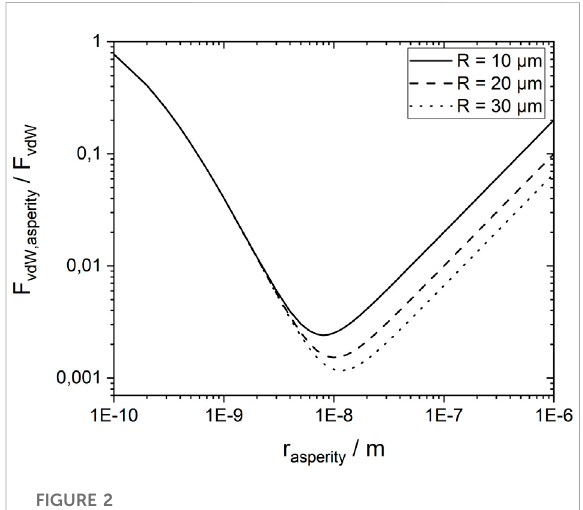
FIGURE 2 vdW interaction force F vdW,asperity between two particles of radius R at contact (contact distance: 0.165 nm) due to an asperity of radius of curvature r (cf. Figures 1B,C) relative to the vdW force interaction between two particles without asperity, F vdW , according to Rumpf (Rumpf,